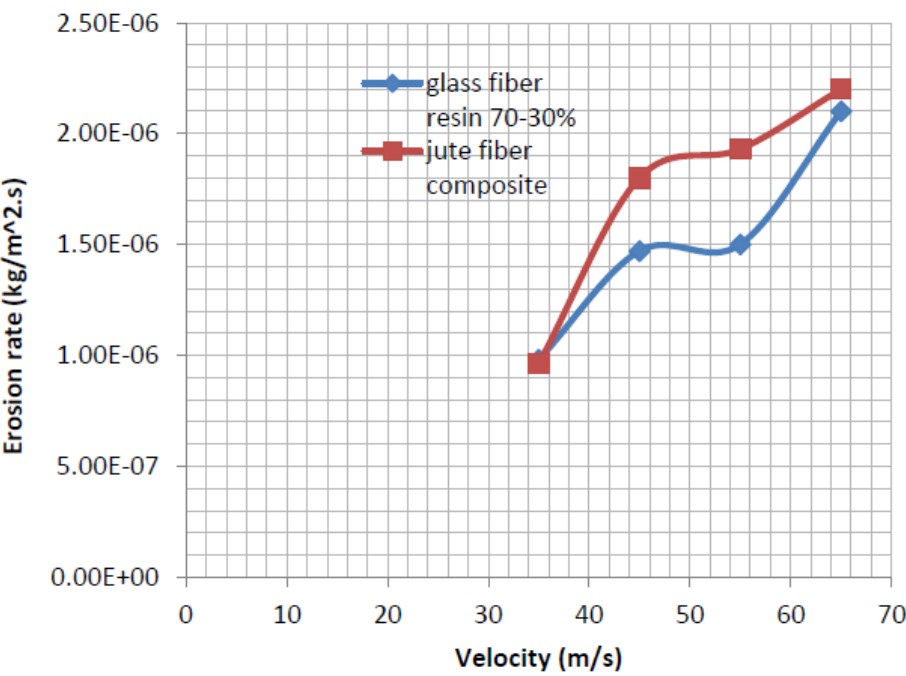
Figure 6: Rate of erosion on two different composite materials for 3 0° angle of attack